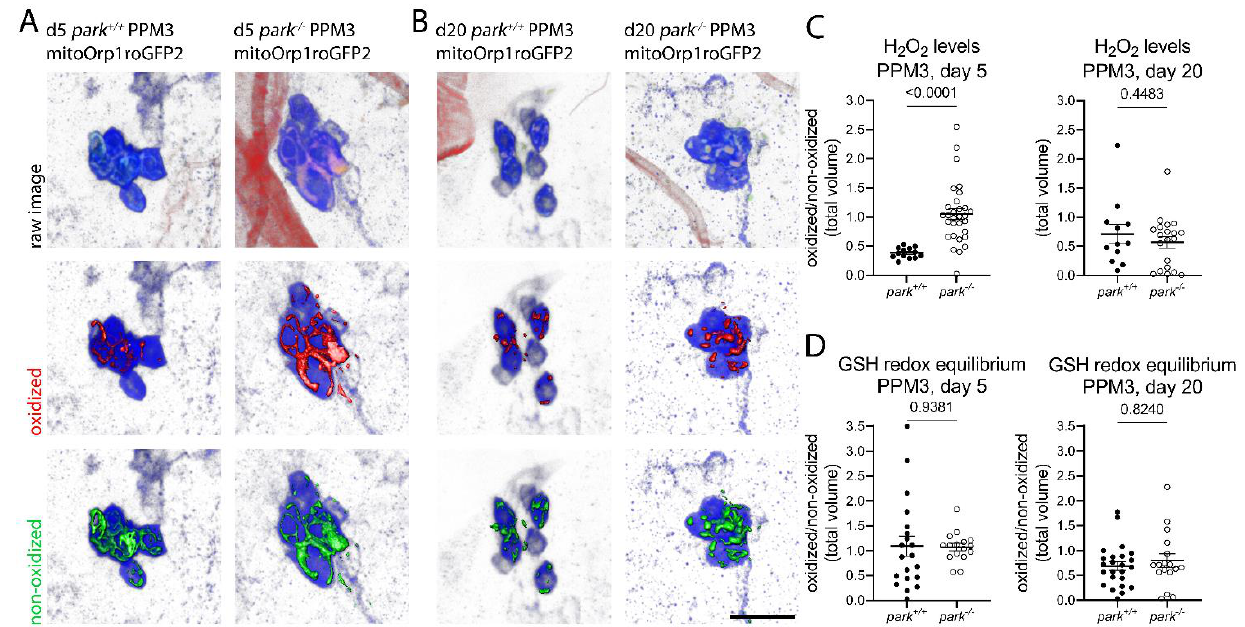
Figure 3. Parkin-null Drosophila have transiently increased PPM3 mitochondrial hydrogen peroxide levels and control levels of glutathione redox equilibrium. Brains were dissected from control ( park +/+ ) or parkin-null ( park −/− ) flies expressing mito-roGFP2-Orp1 or mito-roGFP2-Grx1 on days 5 and 20 post-eclosion, and ratios of total volumes of oxidized to non-oxidized fluorophore emissions were calculated for one PPM3 region per brain. Representative panels of PPM3 images with mito-roGFP2-Orp1 on days ( A ) 5 and ( B ) 20. Raw images are shown in the top row, where blue indicates tyrosine hydroxylase antibody labeling, and red and green indicate oxidized and non-oxidized roGFP2, respectively. Selected volume “isosurfaces” of oxidized (red, middle row) and non-oxidized (green, bottom row) mito-roGFP2-Orp1 above threshold are also shown. Mito-roGFP2-Grx1 images are not shown. Scale bar, 10 µm. ( C , D ) Each data point represents the ratio from one PPM3 region ( n ≥ 12). Welch’s tests and an unpaired t tests were run to determine the effect of genotype for days 5 and day 20, respectively. Error bars represent standard error of the mean, and p values are reported for each comparison.